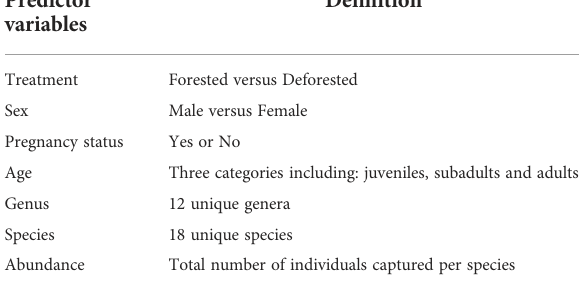
TABLE 1 Description of predictor variables used in the generalized linear